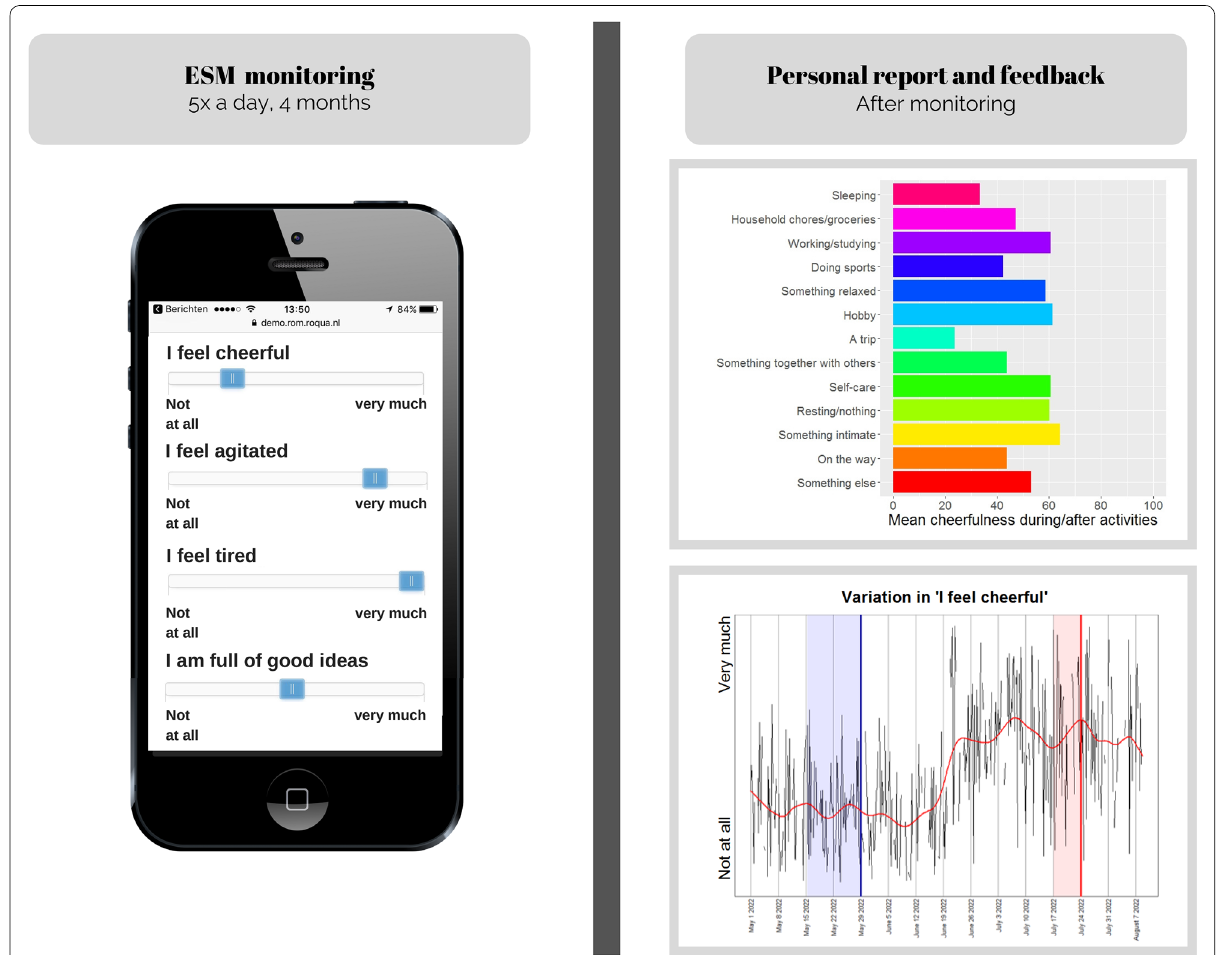
Fig. 1 Visual representation of the ESM monitoring and simulated examples of personalized feedback given to